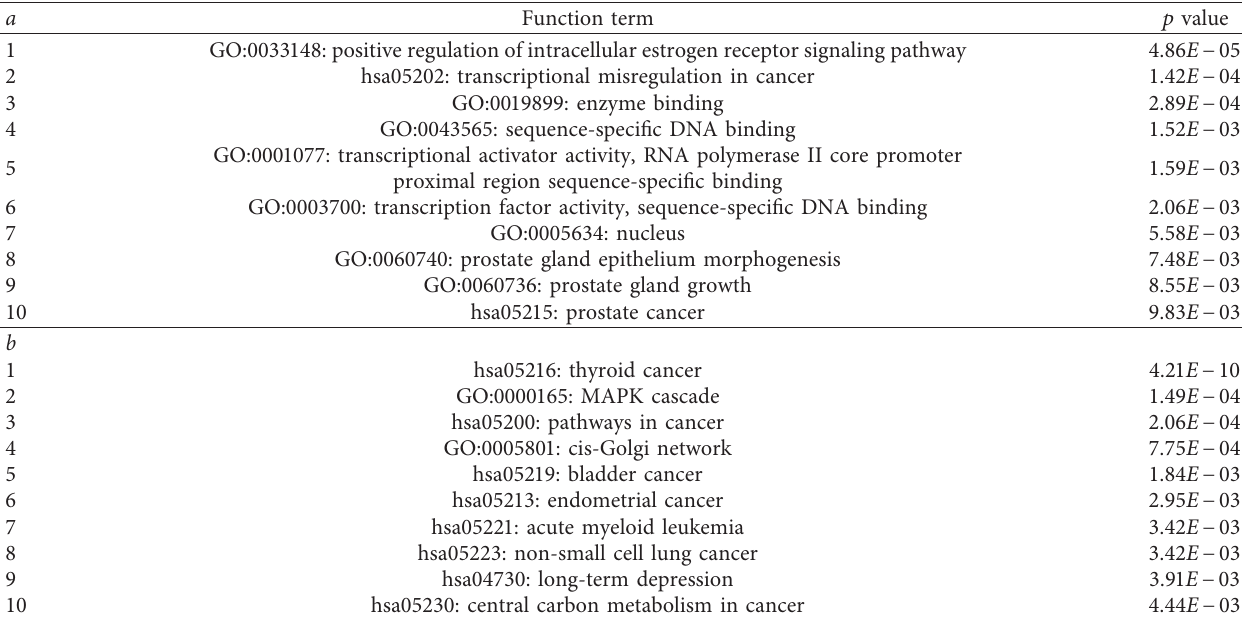
Table 1: Functional enrichment analysis results of our proposed model on STRING network. (a) Enrichment results of prostate cancer. (b) Enrichment results of thyroid